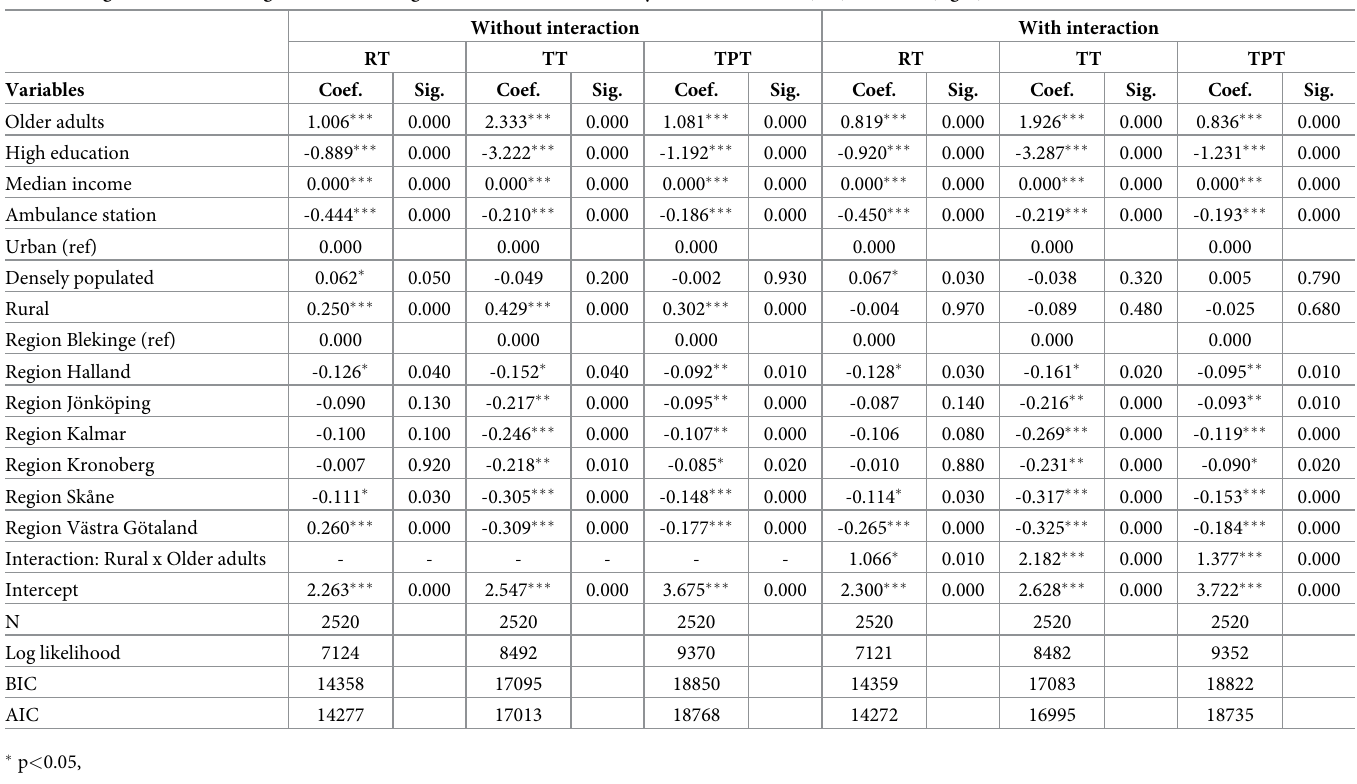
Table 2. Negative binominal regression modelling results for each accessibility measure, without (left) and with (right) interaction effect. Without interaction With interaction